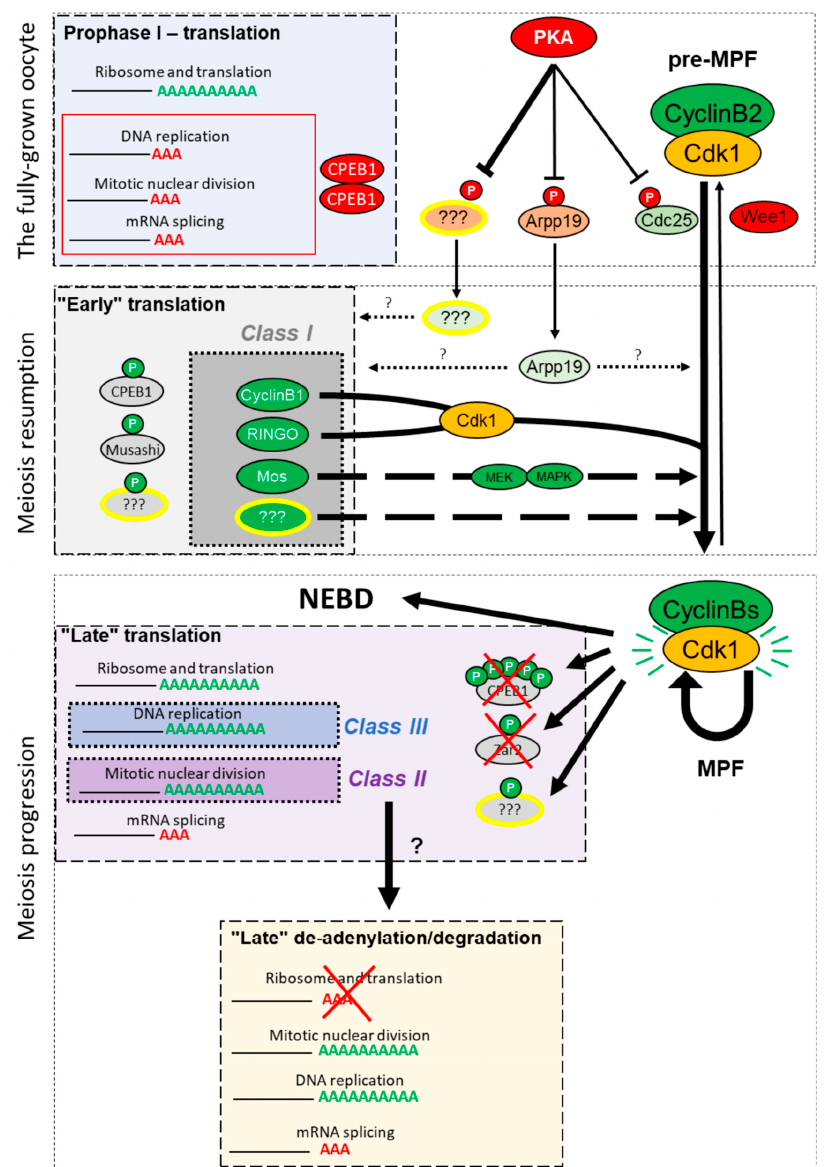
Figure 6. The bidirectional regulation between protein translation and meiosis progression. The fully-grown prophase-arrested oocyte actively translates proteins related to cell metabolism and ribosome biogenesis. mRNAs encoding proteins involved in M-phase progression, DNA replication, and mRNA splicing exhibit short poly(A) tails and are stored for future translation. The prophase arrest is maintained by the high activity of protein kinase A (PKA) and the phosphorylation of its substrates, which indirectly inhibit the activation of the M-phase promoting factor (MPF). In the vertebrates, the prophase arrest is released by a decrease of PKA activity and the dephosphorylation of PKA substrates. De novo protein synthesis occurs before NEBD (“Early” translation), and a sub-group of the de novo synthesized proteins is required to activate Cdk1 (Class I). Two RNA-binding proteins (RBPs) have been involved in the activation of the early translation wave—CPEB and Musashi. Once activated, Cdk1 activates the “late translation” (purple box). This second translation wave involves the phosphorylation and degradation of inhibitory RBPs, including CPEB1 and Zar2. The translated proteins are involved in meiosis progression (Class II), support embryonic cell divisions, such as components of the DNA replication machinery (Class III), and further contribute to regulating RNA translation and degradation by de-adenylation in metaphase II. Among the transcripts that are de-adenylated are ribosome compounds and translation initiation